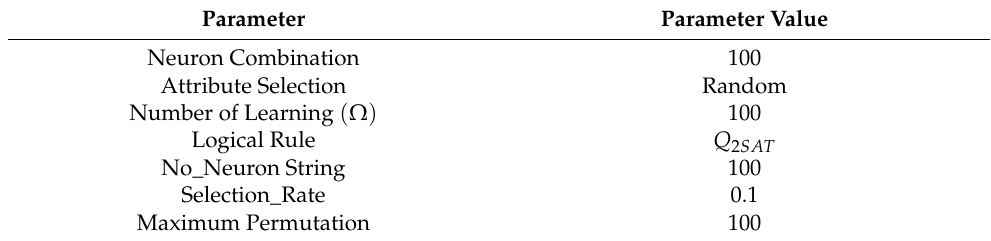
Table 5. List of parameters in P2SATRA